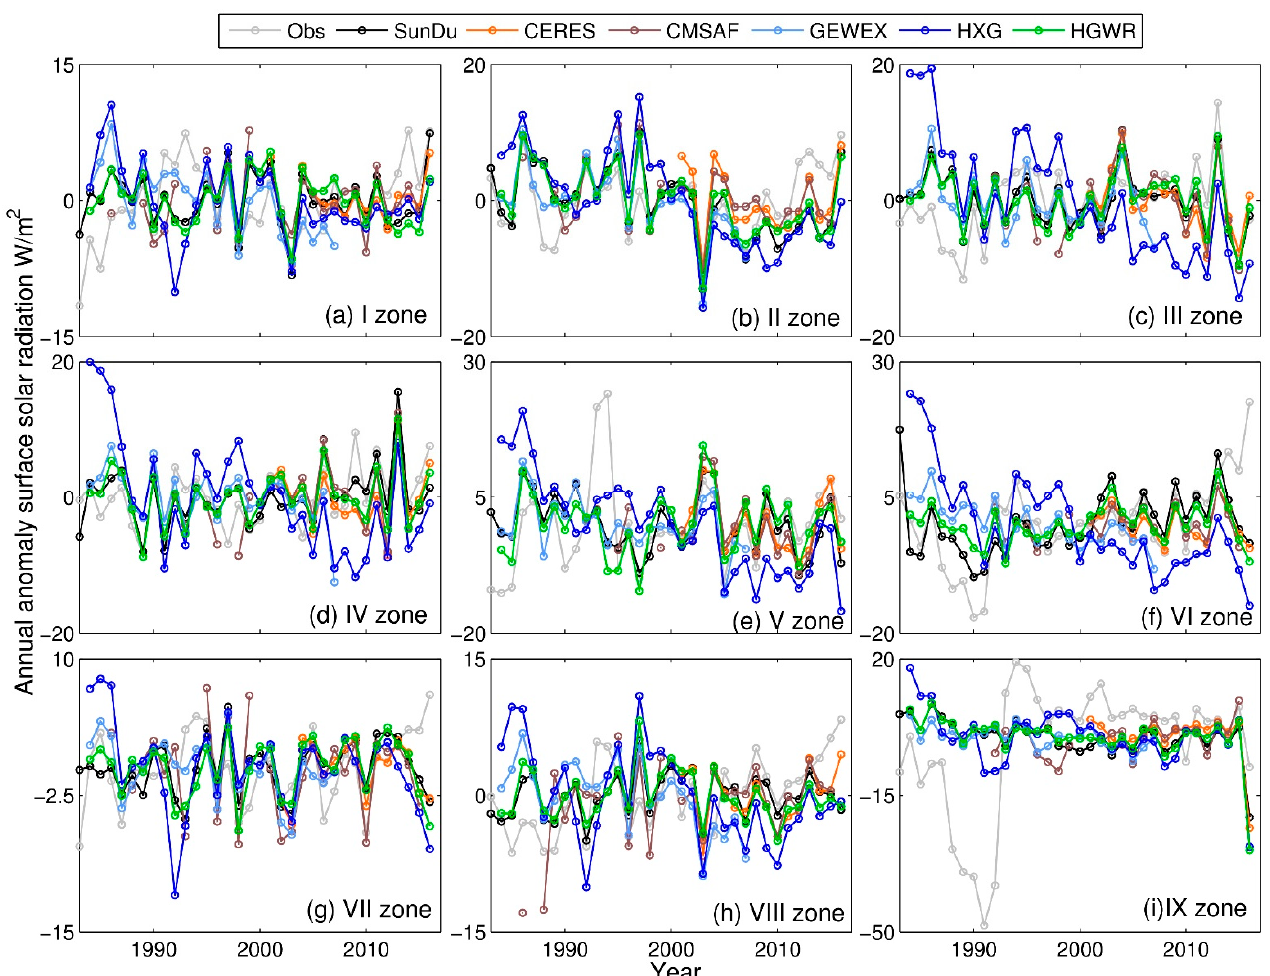
Figure 7. The regional mean of the annual anomaly of the R s for different subregions. Nine subregions (I to IX) over China are shown in Figure 1. The direct observed R s data, SunDu-derived R s and CERES EBAF are shown as the light grey lines, the black lines and the orange lines. The brown lines, the light blue lines and the blue lines represent the R s variation derived from the CMSAF CLARA A2 (CMSAF), GEWEX-SRB (GEWEX) and ISCCP-HXG derived R s (HXG), respectively. The ISCCP-HXG derived R s merged with SunDu derived R s (HGWR) is shown as the green lines. Table 1. Statistical summary of national mean linear trends of monthly anomalous surface solar radiation ( R s ) (10 yr) derived from observations and satellite retrievals, including direct observa- tions (Obs), SunDu-derived Rs (SunDu), CERES EBAF (CERES), GEWEX-SRB (GEWEX), CMSAF CLAR A2 (CMSAF), ISCCP-HXG (HXG) and merged Rs data (HGWR).